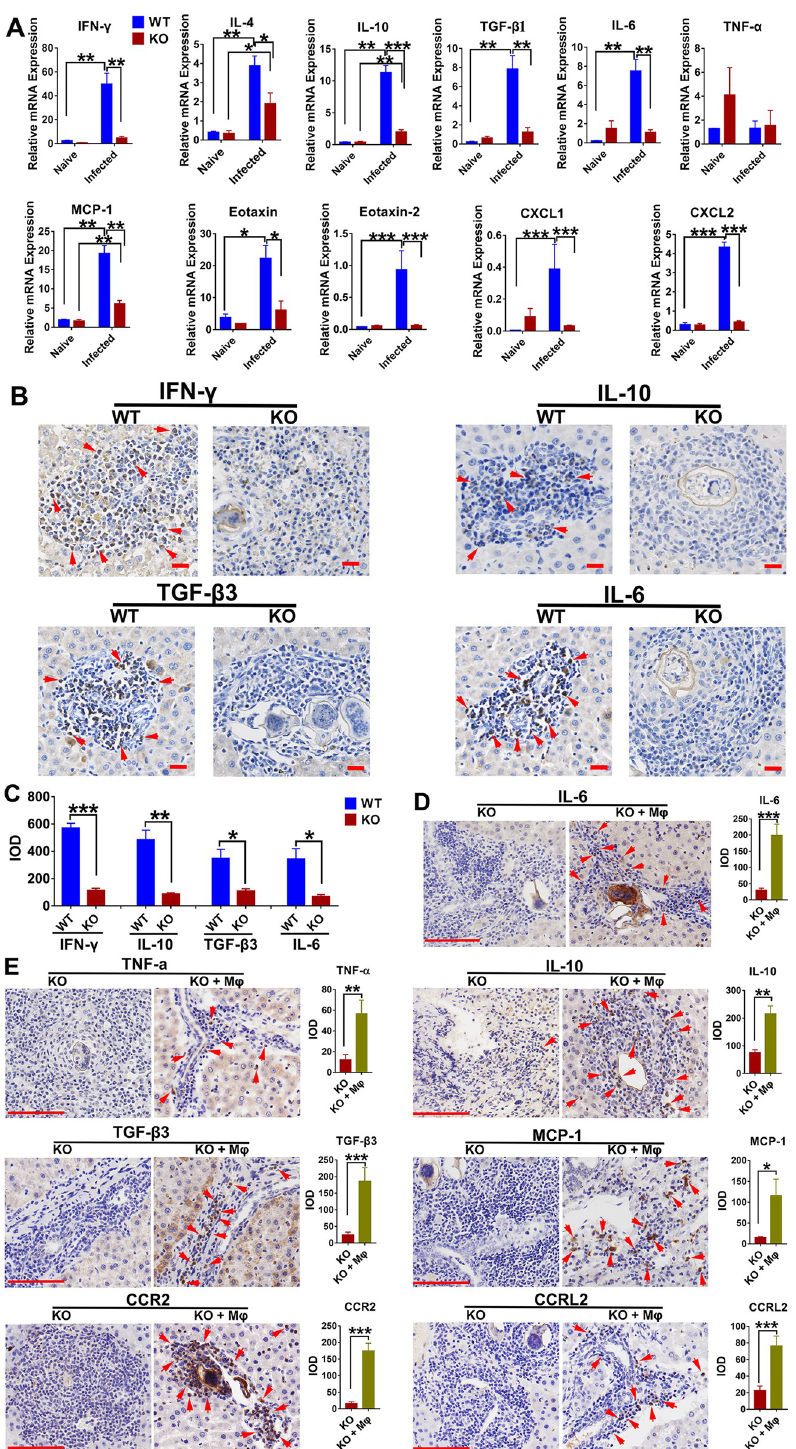
Fig 5. Cytokine and chemokine production is impaired in the liver of infected iNOS-KO rats. WT and KO rats were infected percutaneously with 200 S . japonicum cercariae and sacrificed at 7 weeks post-infection. (A) Relative mRNA levels of cytokines and chemokines in liver tissue were determined by real-time PCR. Expression is normalized to β -actin. Data shown are mean ± SEM and repeated twice with similar results, n = 5 rats per group. Significant differences have been noted, � P < 0.05, �� P < 0.01, ��� P < 0.001. (B) Hepatic granuloma-associated